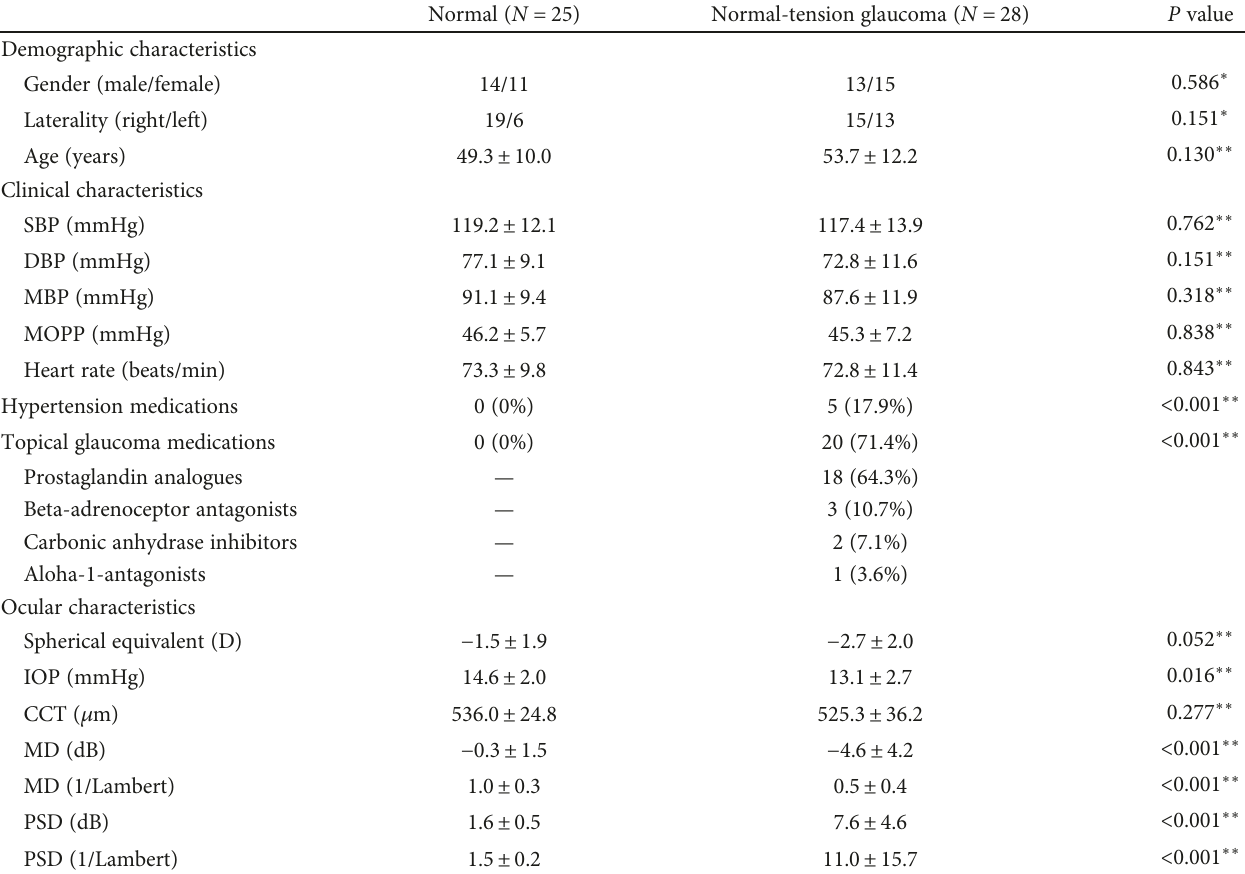
Table 1: Demographics and ocular characteristics of normal subjects and normal-tension glaucoma